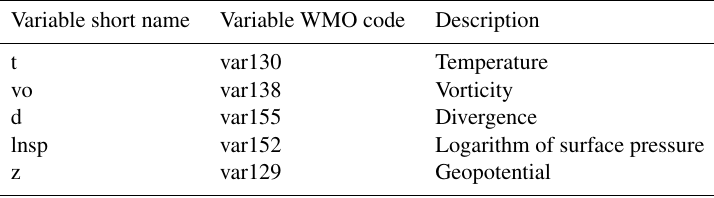
Table A2. Model-level variables in spherical harmonics representation in the ICMSHoifsINIT file.